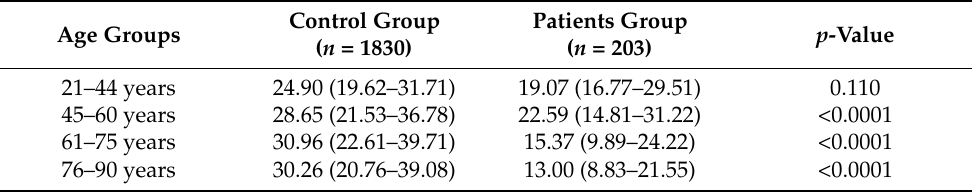
Table 2. The comparative analysis of vitamin D serum levels between COVID-19 and non-COVID-19 patients.